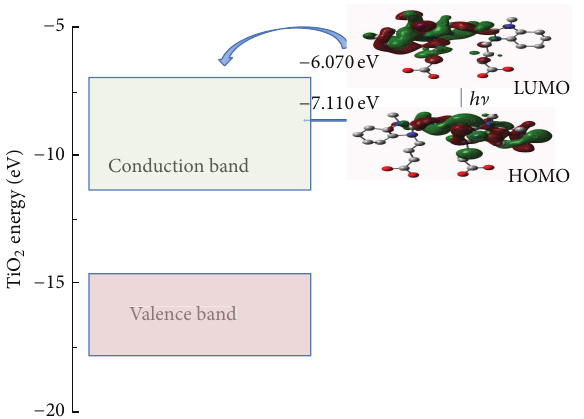
Figure 7: Schematic simplified representation of the energy level diagram of Dye 1 (HOMO-LUMO) and TiO 2 (VB-CB). Arrows represent possible electron transport pathway from Dye 1 to CB of TiO 2 . Light absorption results in creating excited state Dye 1 (HOMO-LUMO transition) from which charge transport to the CD of the TiO 2 is possible (curved arrow). Horizontal arrow indicates possible direct charge transport from the HOMO of Dye 1 to TiO 2